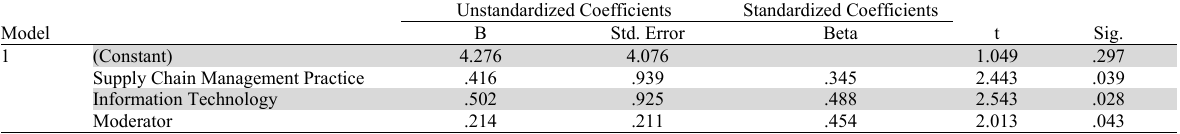
T-test results for information technology as moderating variable